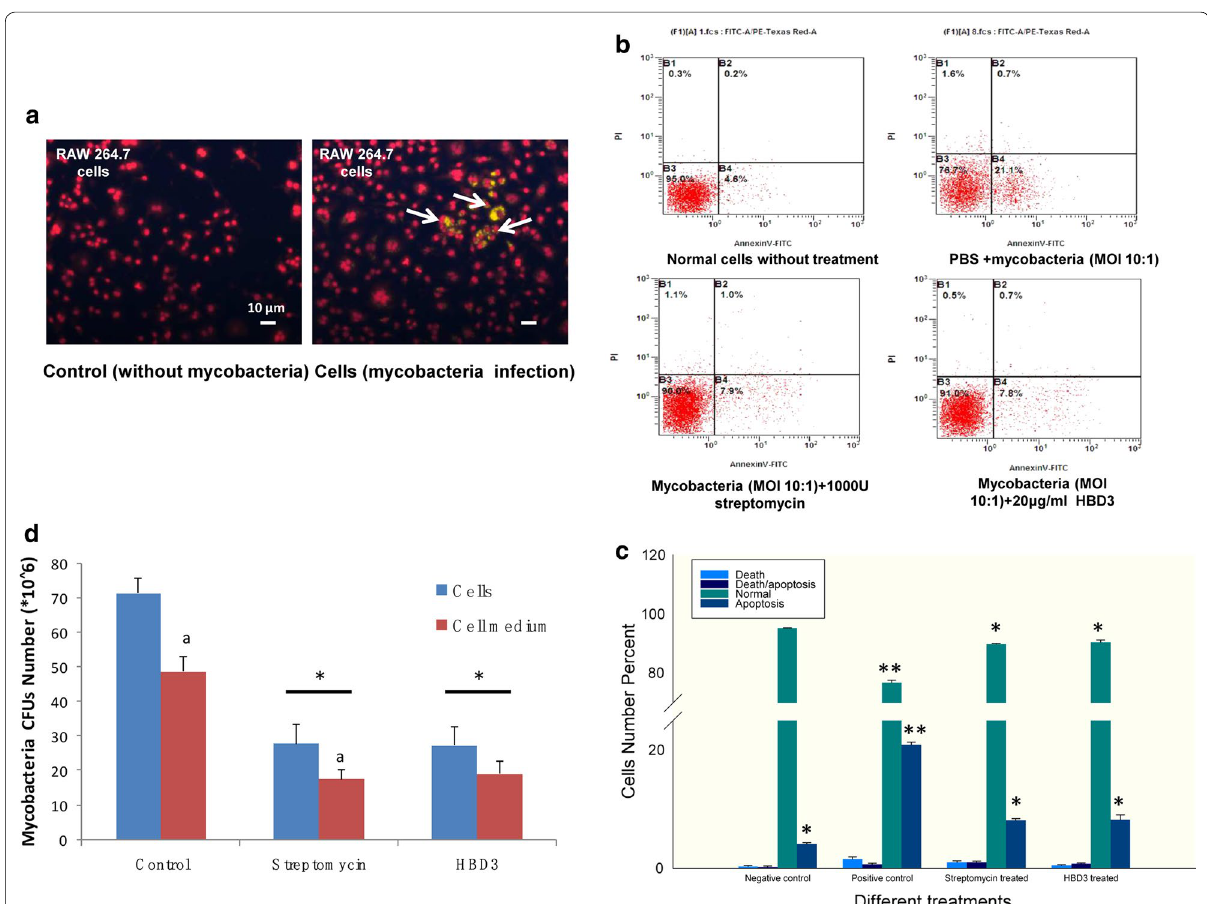
Fig. 5 Mycobacterium bovis resistant capacity analysis of rHBD3 protein to macrophage. a Mycobacteria invasion tests. Yellow spots in the figure are Mycobacteria . b Cell apoptosis analysis of macrophage infected by M. bovis with different treatments. c The data of cell apoptosis and death ratio analysis of macrophages infected by M. bovis with different treatments. All the experiments were replicated three times and the changes are presented as mean SEM. P values < 0.05 were considered as statistically significant. d CFU tests in macrophage and its medium (a,*P < ±